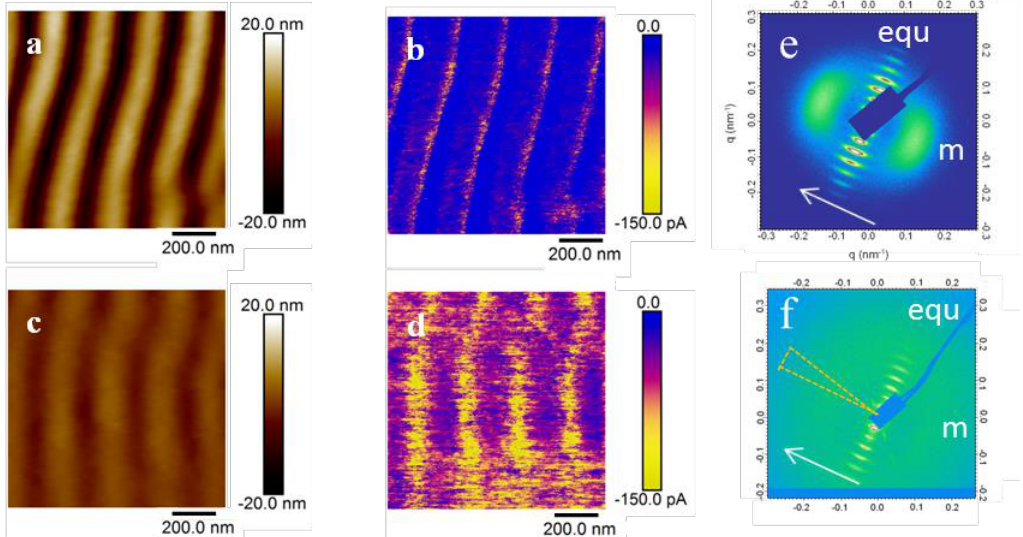
Figure 6. AFM topography of LIPSS on P3HT:P 71 CBM (1:1) fabricated at λ laser = 266 nm in vacuum: ( a ) Before and ( c ) after annealing. Current images of the same samples: ( b ) Before and ( d ) after annealing. Annealing conditions are 4 min at 140 ◦ C. Resonant soft X-ray scattering (RSoXS) patterns at E = 284.2 eV ( e ) before and ( f ) after annealing. The arrows indicate the direction of the ripple axis of the LIPSS. The angular sector indicated in ( f ) refers to the range used for the angular integration of the scattered intensity.